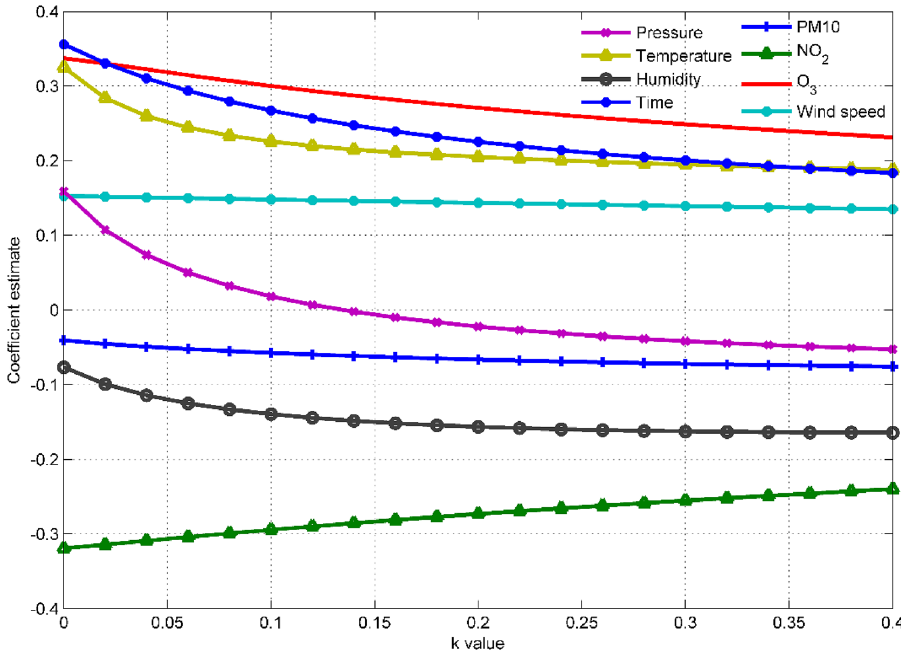
Figure 5. The ridge trace diagram of the input variable after the variable selection is completed, where the dependent variable is the O 3 concentration measured by the national control point.